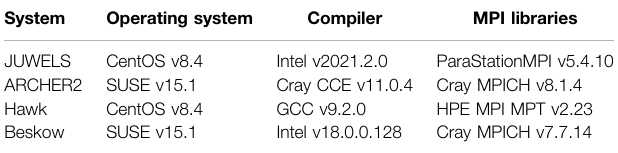
TABLE 3 | Overview of the software environment of the HPC systems.